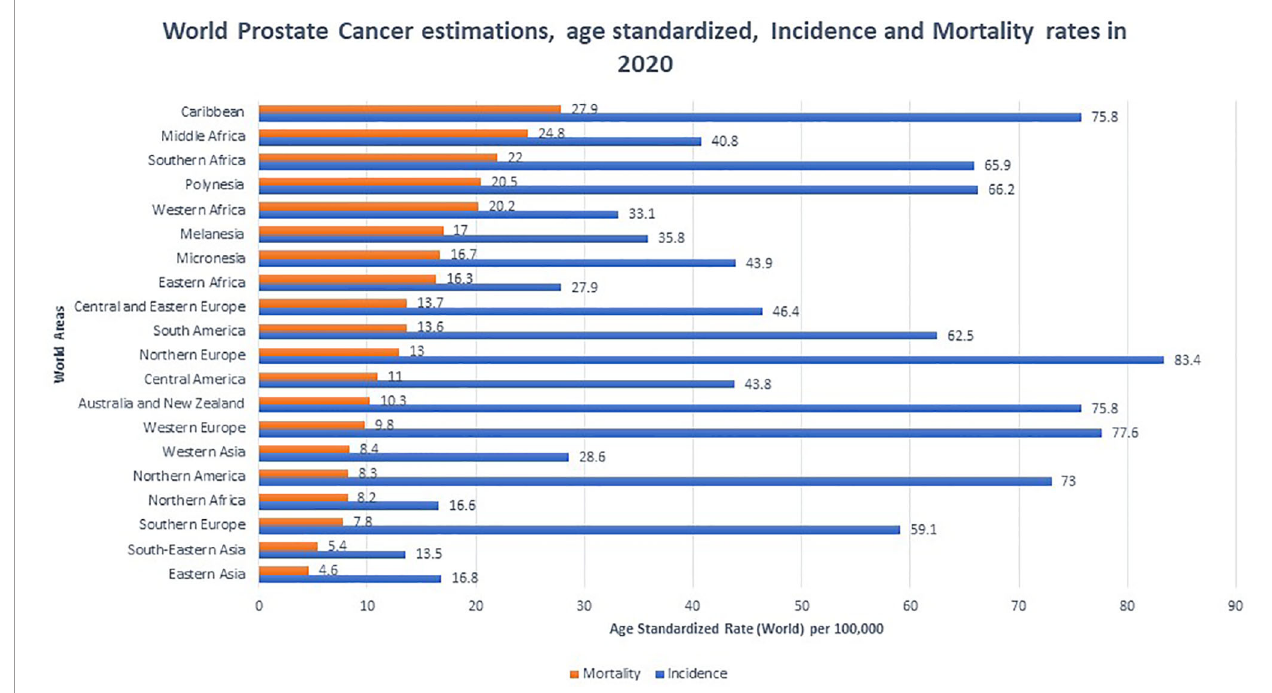
FIGURE 1 | Global prostate cancer incidence and mortality by World Areas. Graph indicates age standardized incidence (Blue) and mortality rates (Orange), per 100,000. Mortality rates were sorted from highest to lowest